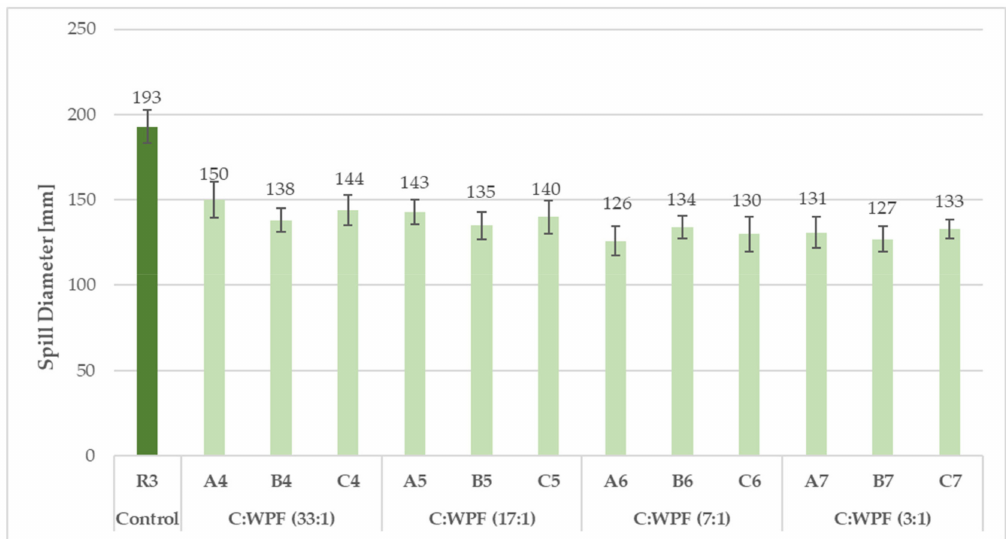
Figure 5. Mean spill diameter values for reference and fiber-cement fresh mixtures based on WPF samples (A, B, and C) with different C/WPF ratios (set II).